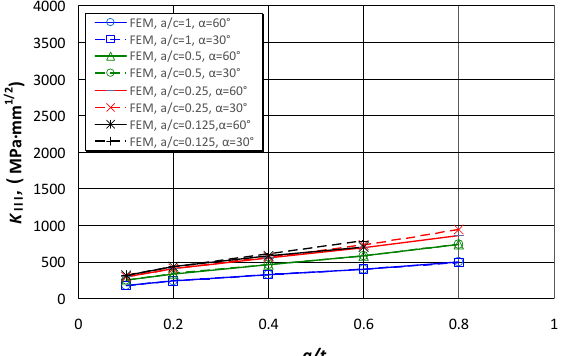
Figure 14. SIF solutions for third mode of crack opening.